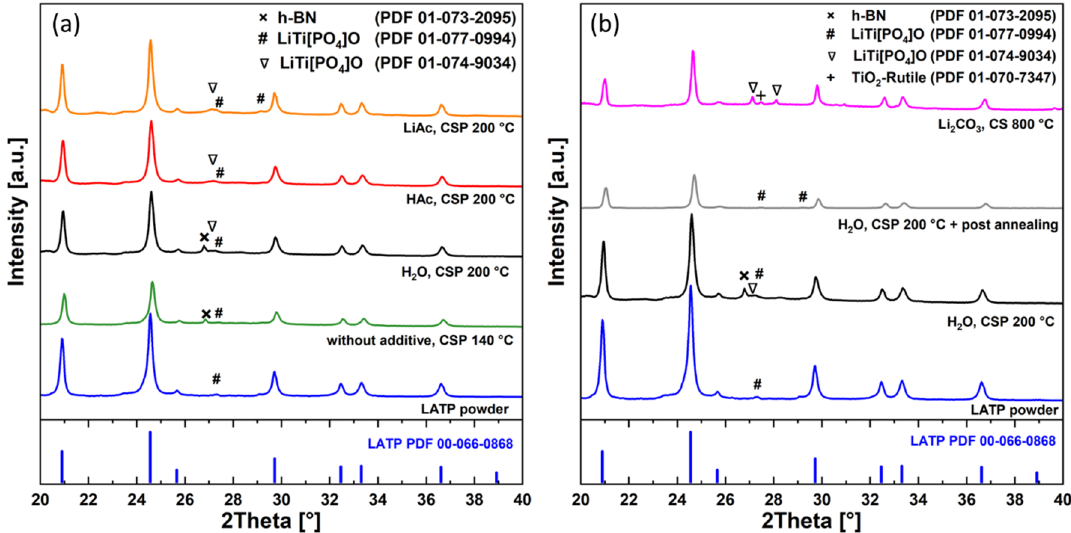
Figure 8. XRD patterns of the ( a ) cold-sintered samples compared with that of the as-prepared pow- der and ( b ) post-annealed and conventionally sintered LATP compared with as-prepared powder and cold-sintered